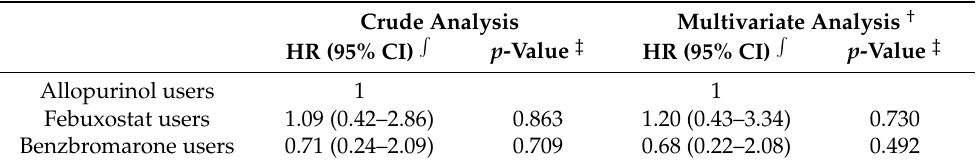
Table 3. Cox proportional hazards model of AF development between patients with gout receiving treatment with different urate-lowering drugs.